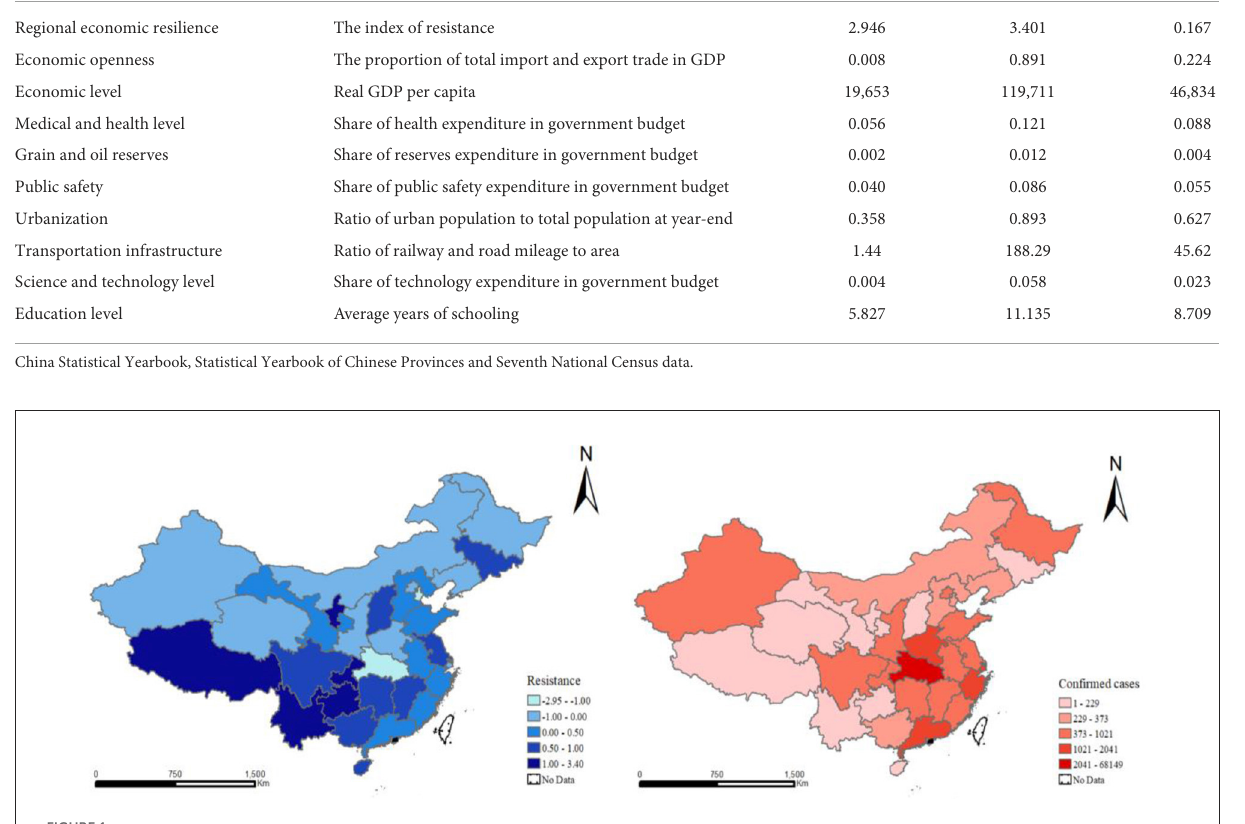
and widespread spread of the virus is more likely due to the high urbanization rate and high population mobility in developed provinces and cities. So, in order to curb the spread of the